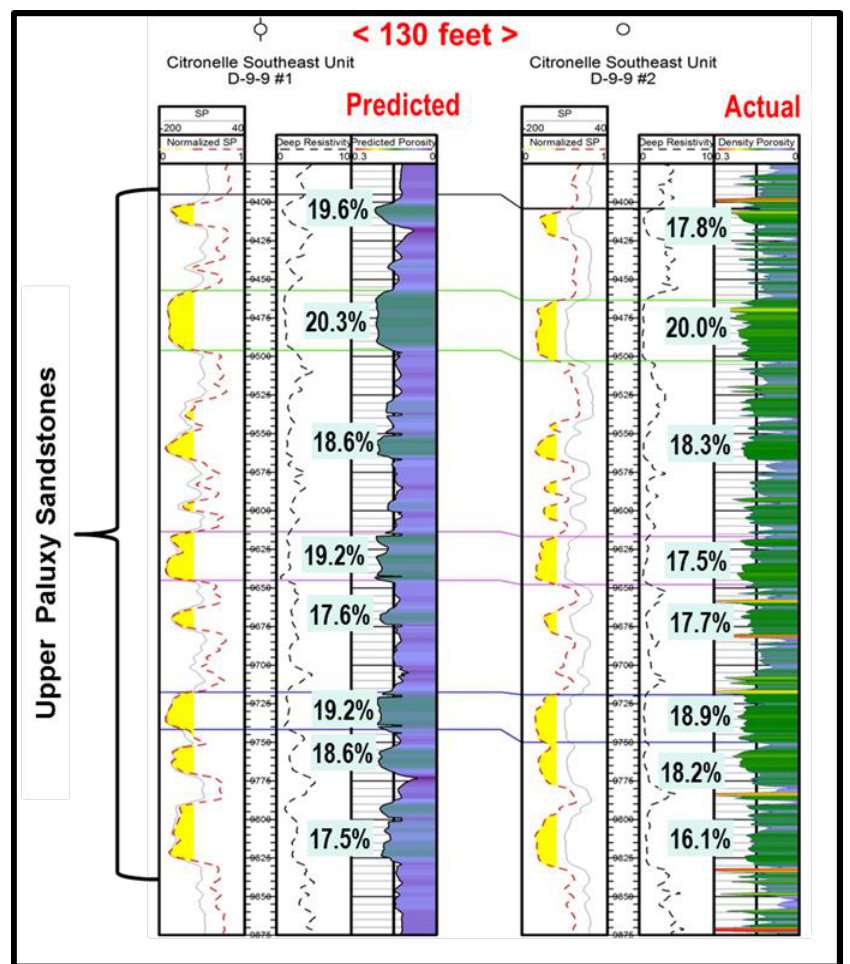
Figure 7. (Left) Predicted neural network porosity curves compared with actual density porosity logging measurements (Right) at the D-9-9 #1 and #2 well pair. Paluxy sand reservoirs are highlighted in yellow on the SP log. The wells are spaced 130 feet/40 meters apart. The predicted Artificial Neural Network curve was generated from MatLab® . The actual porosity curves shown use Petra® .